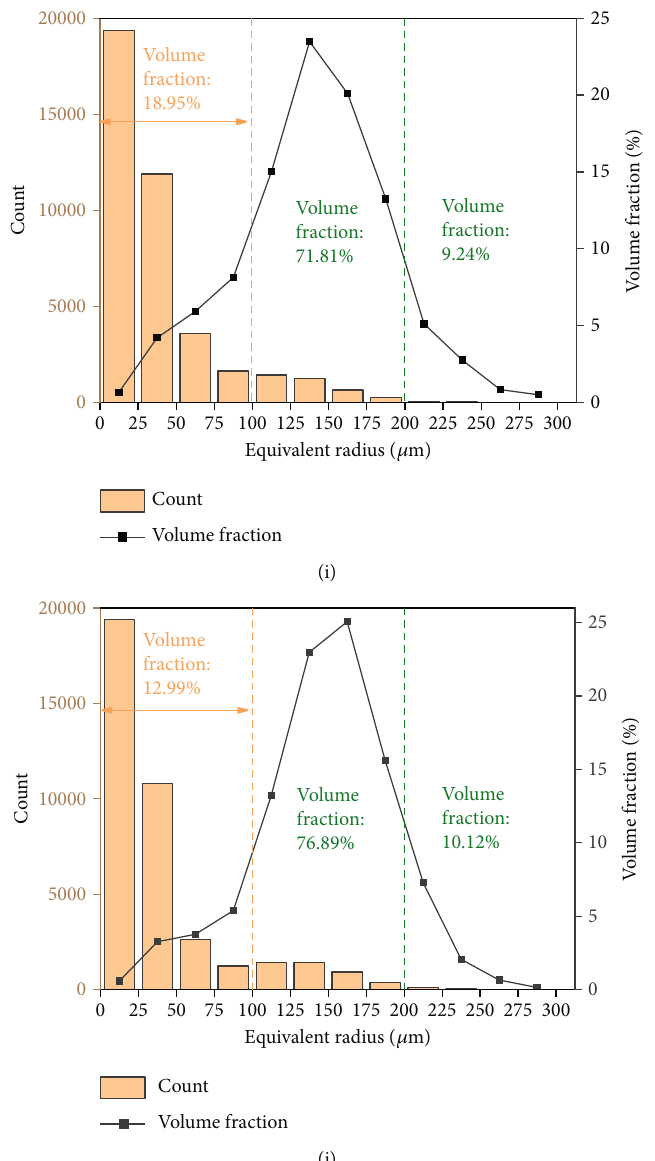
Figure 10: Distribution map of the equivalent pore radius and volume percentage of fi ve red sandstone samples with di ff erent saturations after 60 freeze-thaw cycles. In (a, c, e, g, i), samples A, B, C, D, and E have undergone 0 freeze-thaw cycles, respectively. In (b, d, f, h, j), samples A, B, C, D, and E have undergone 60 freeze-thaw cycles,